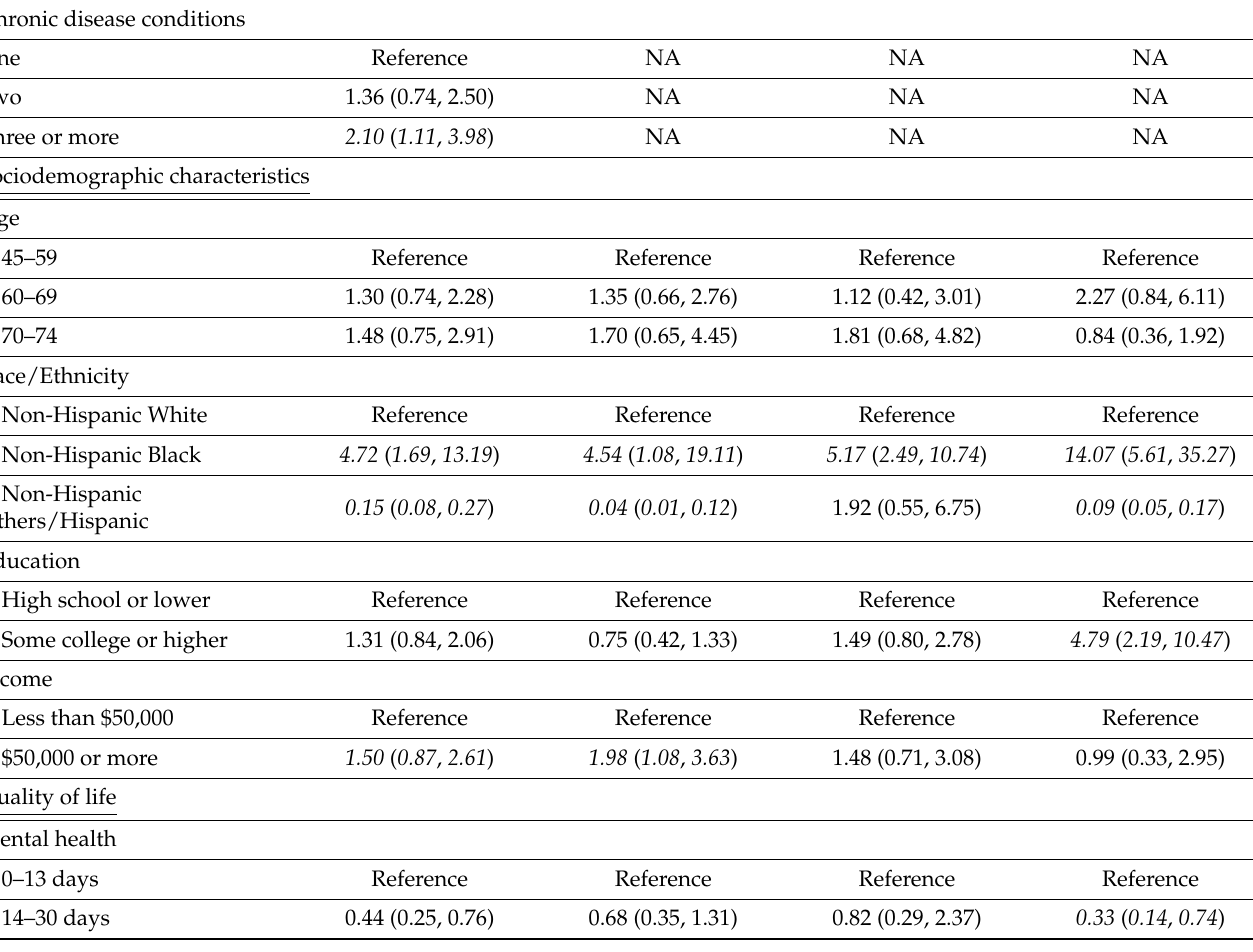
Table 2. The association between sociodemographic characteristics, cancer related factors, quality of life, and CRC screening use and stratified by chronic disease conditions. Total One Two Three or More OR (95% CI)